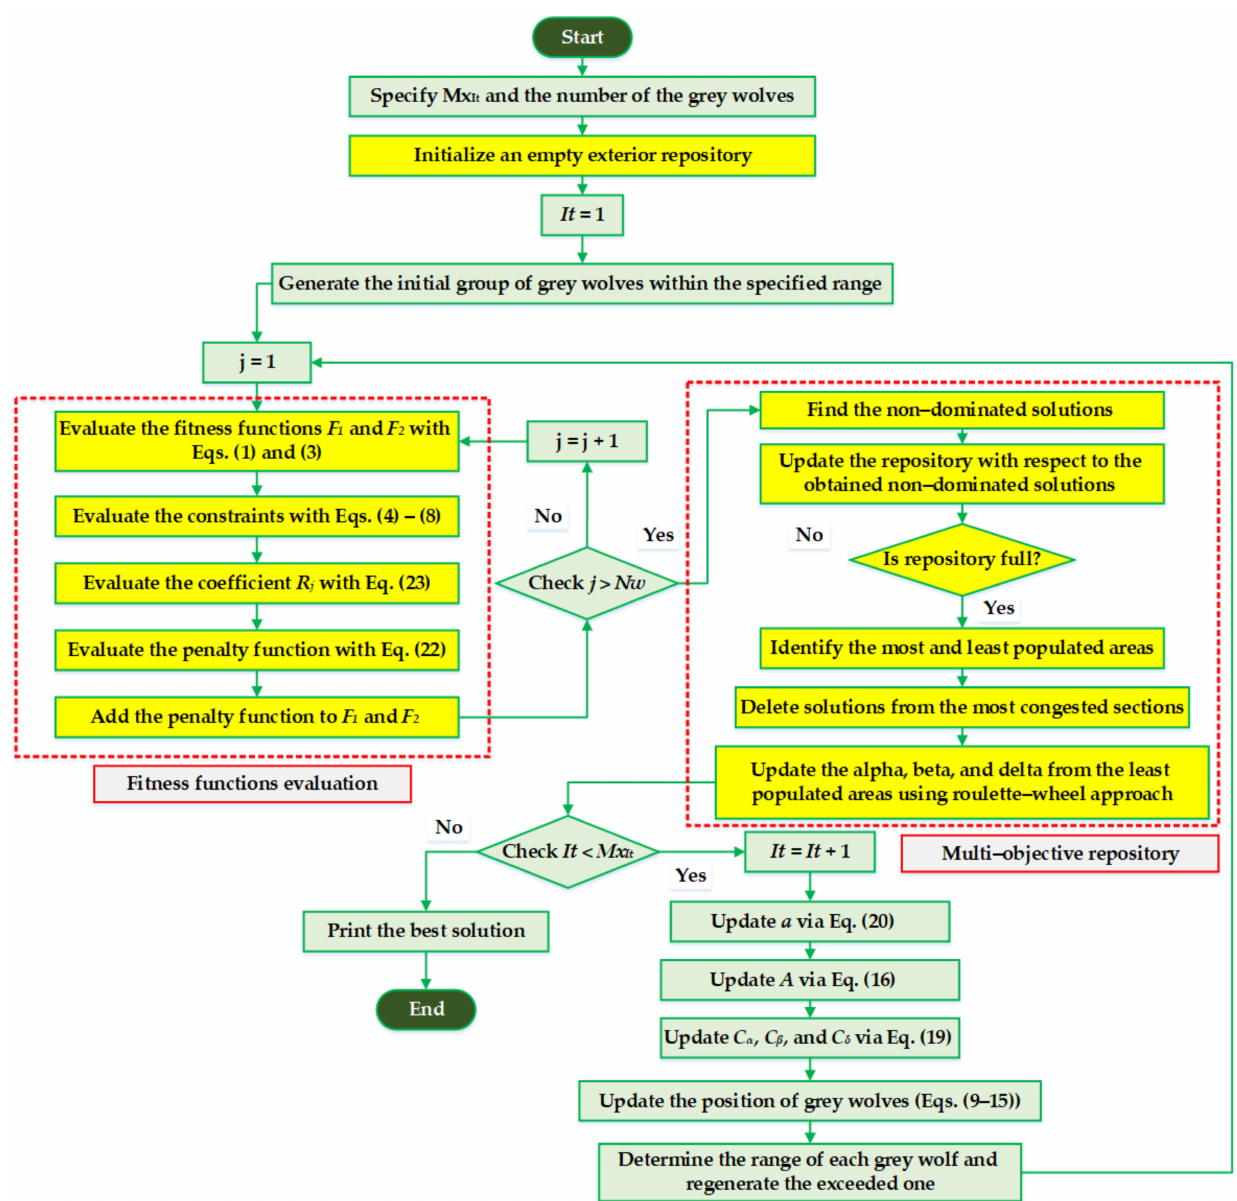
Figure 5. Main steps of the developed MGWO for TLSM